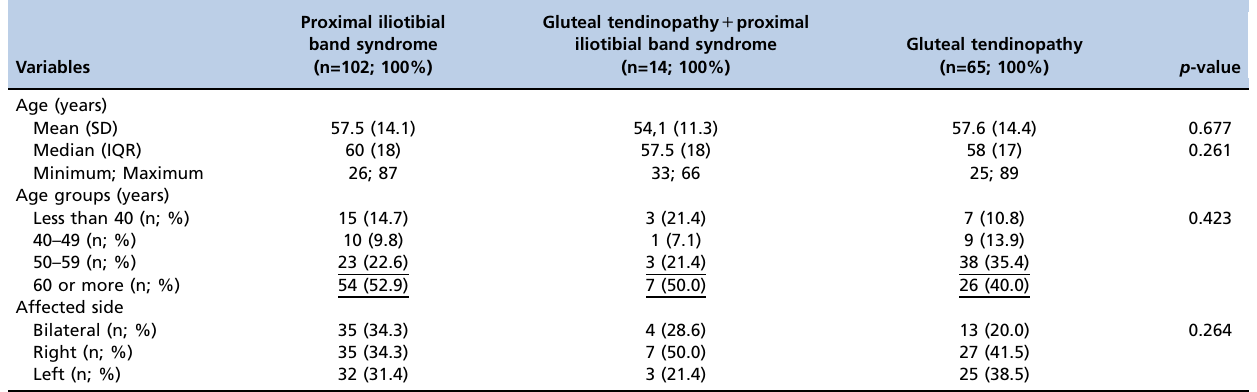
Table 2 - Descriptive and comparative analysis of cases specifically by diagnosis.